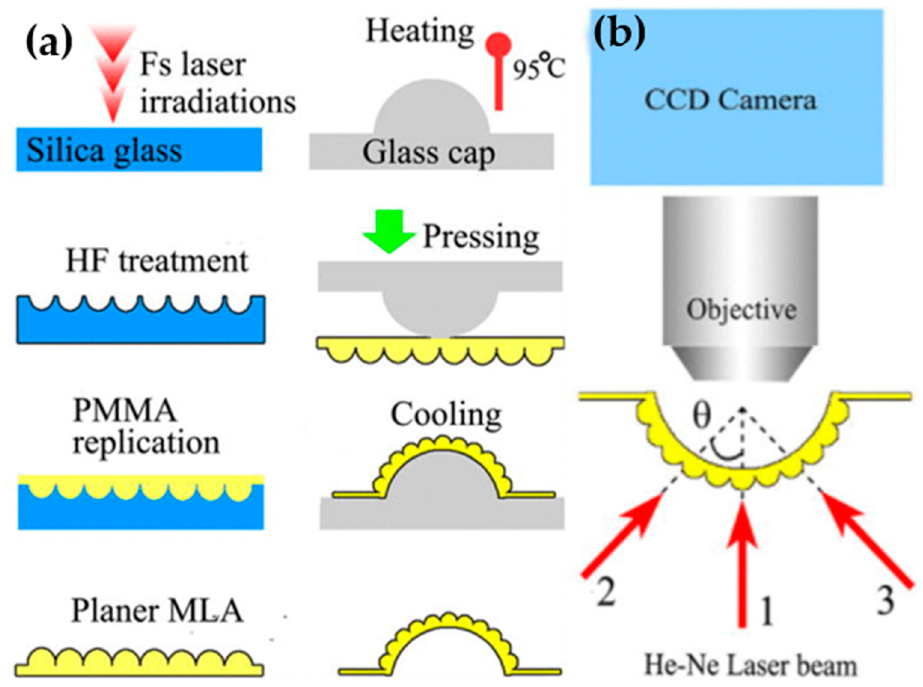
Figure 10. ( a ) The schematic diagrams of the fabrication process. ( b ) The optical setup experiments. Reproduced from [41], with permission of AIP Publishing.